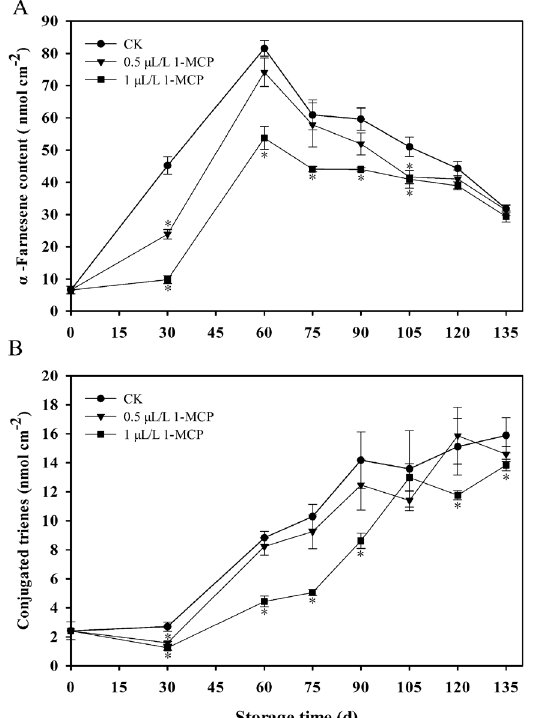
Fig. 3: Effects of 1-MCP on H 2 O 2 content (A) and activities of APX (B), SOD (C), and CAT (D) in ‘Wujiuxiang’ pear fruits during storage at 0 °C. The data are the means ± SE of three replicates. The vertical bars represent the standard errors of the means. Star represents significant difference ( P <